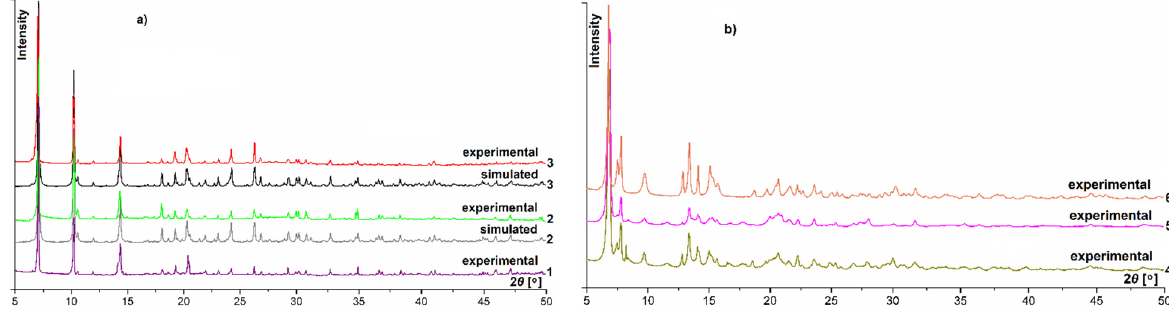
Figure 2. Powder profiles for orthorhombic ( a ) and monoclinic ( b ) complexes over the 2 θ angle range from 5 to 50°.